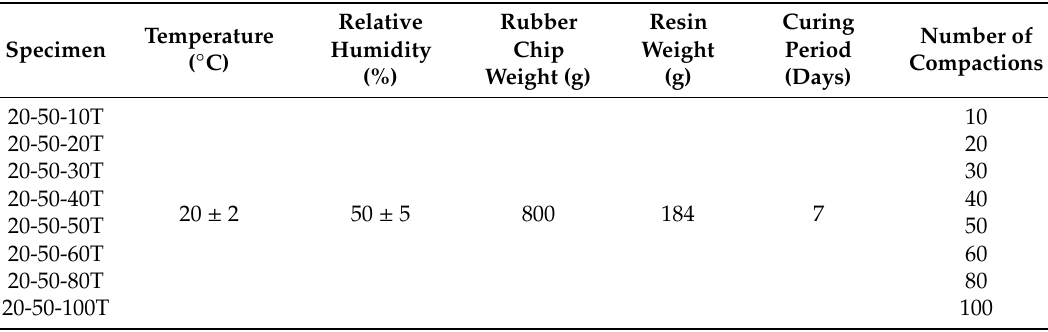
Table 1. Test variables used to evaluate the e ff ects of the number of